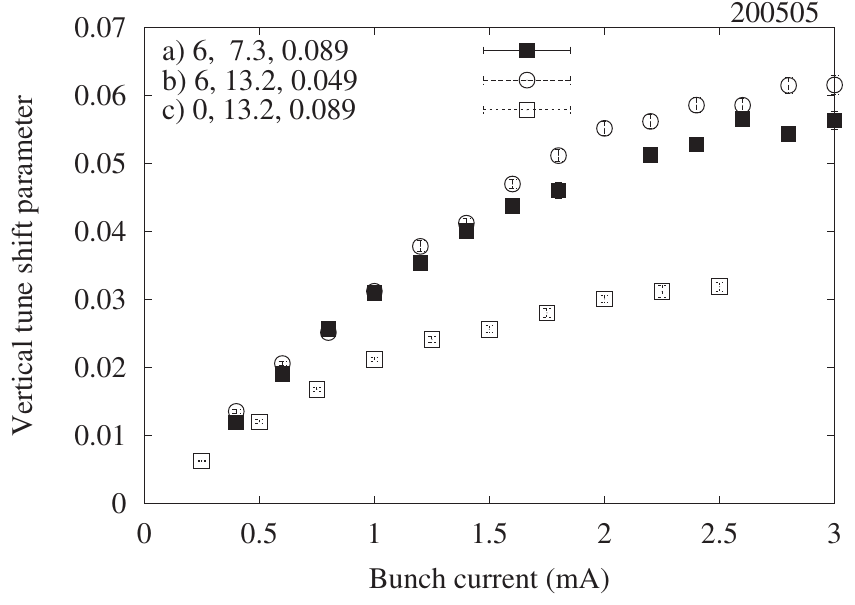
(cid:1) 6 m with high Q FIG. 15. Simulated luminosity for the CESR - c optics with (a) M 56 (cid:1) 6 m with low Q (cid:1) 0 : 049 and (cid:3) (cid:1) 13 : 2 mm ), and (c) standard CESR - c optics, M and long bunch, ( Q 7 : 3 mm ), (b) M s s l 56 (cid:1) 0 : 089 and (cid:3) (cid:1) 13 : 2 mm ). ( Q s l (cid:1) 0 : 089 . (Note 13.2 mm when the synchrotron tune is Q s (cid:1) 12 mm and (cid:10) (cid:1) 0 : 0113 .) In order to explore that (cid:4) (cid:5) v p (cid:1) 6 m so that Q M 56